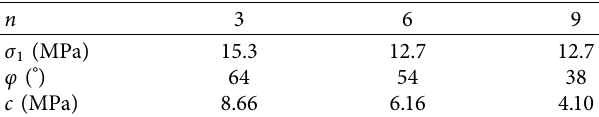
Figure 14: Failure modes of the red sandstone samples under various dry-wet cycles: (a) n � 0, (b) n � 1, (c) n � 3, (d) n � 6, and (e) n � 9. Table 6: Variation of φ and c with the number of dry-wet cycles of the red